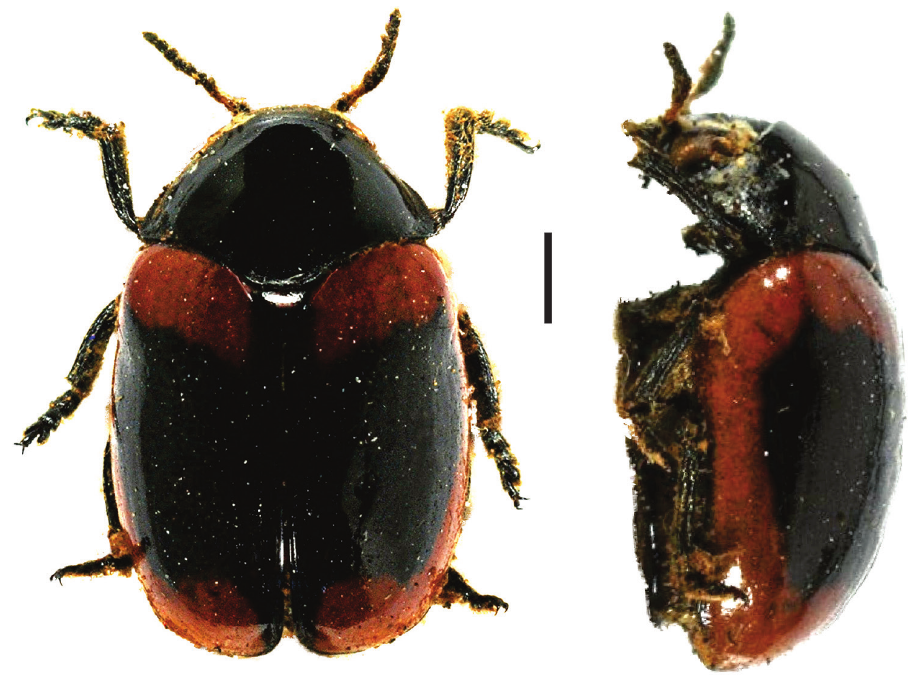
Figure 15. Urodera ( Austrurodera ) circumcincta circumcincta Lacordaire (3) , left: habitus (dorsal view), right: habitus (lateral